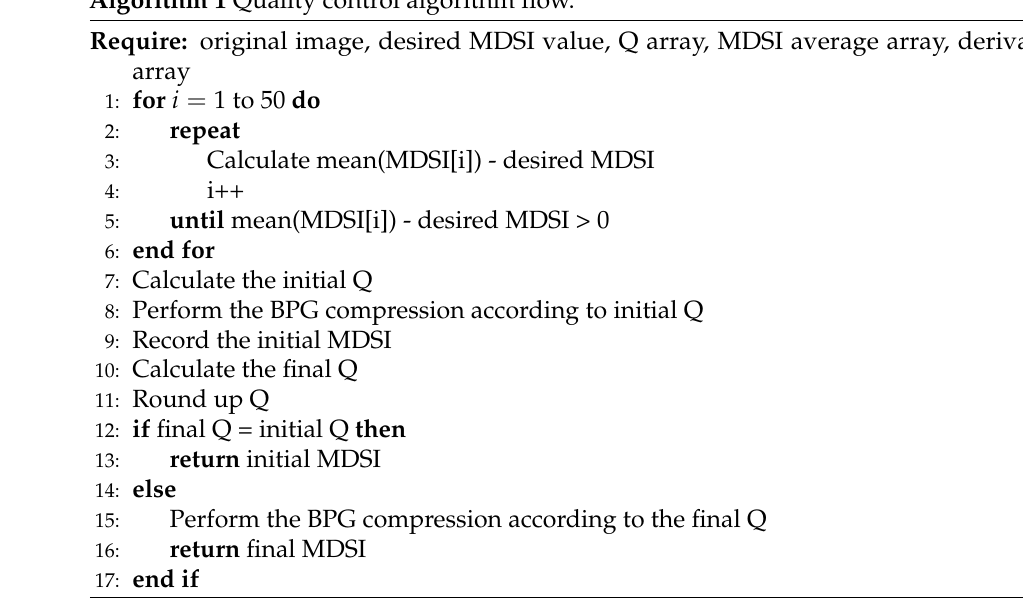
Algorithm 1 Quality control algorithm flow.